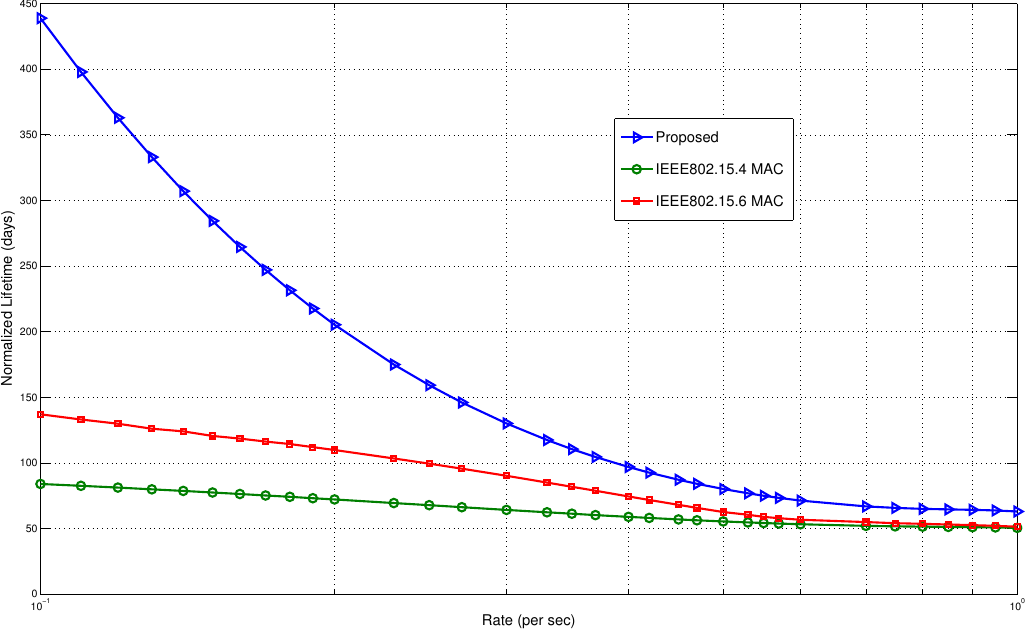
Figure 28. Lifetime comparison with standard